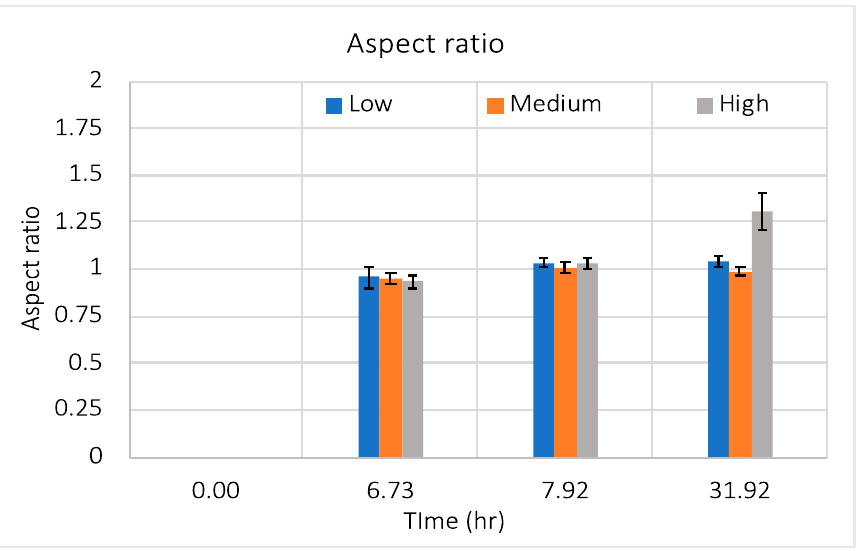
Figure 7. Measurement of aspect ratio for as-spun fiber and after calcination.